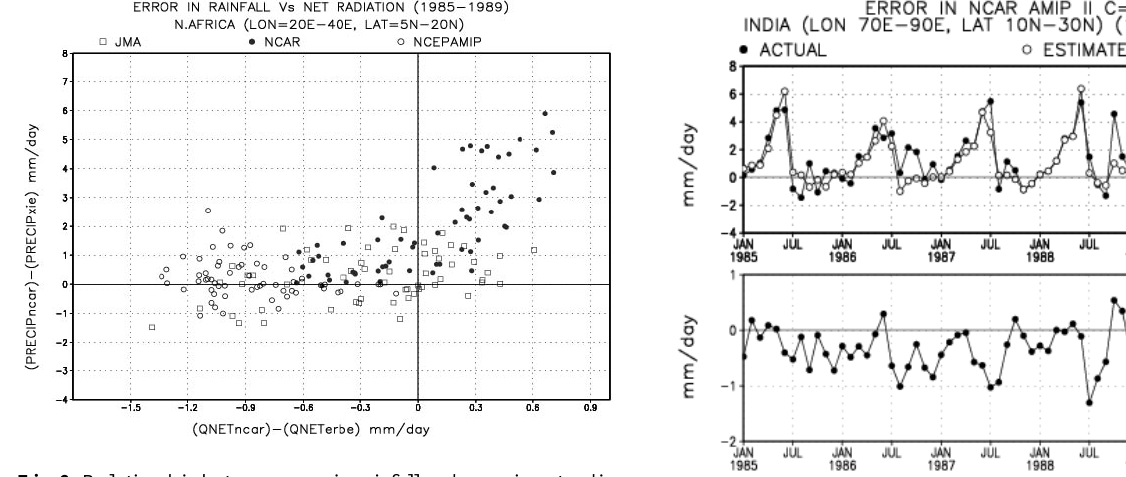
Fig. 9. Relationship between error in rainfall and error in net radia- tion in North Africa.